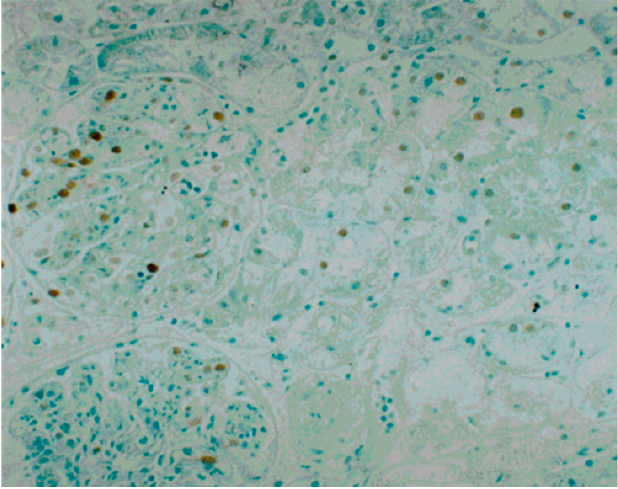
Figure 5. Immunoperoxidase staining for proliferating cell nuclear antigen (PCNA) and counter- staining with methyl green in a renal biopsy tissue from a PSAGN patient (original magnification, × 100) [23]. Prominent expression of PCNA in the glomerulus and tubular epithelial cells was ob- served. The distribution of PCNA-positive cells was variable; i.e., there was a considerable difference in the number of PCNA-positive cells between each glomerulus and between different parts of the tubules.